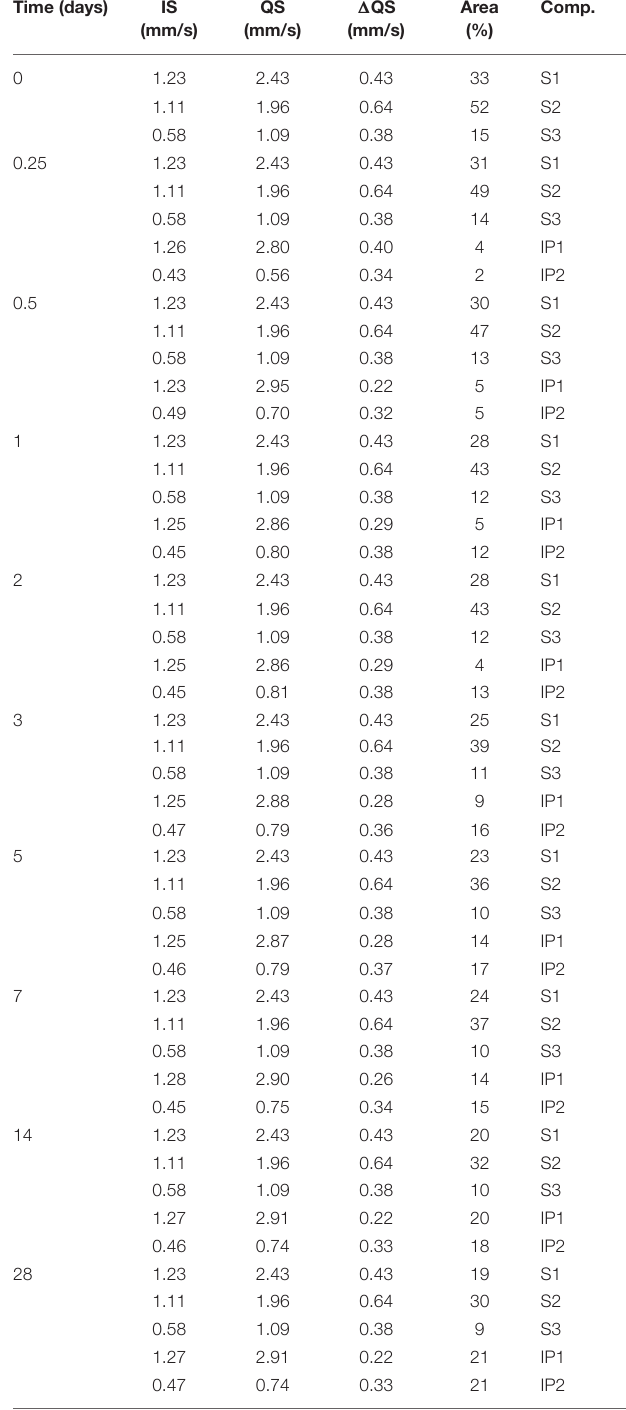
TABLE 2 | Resulting hyperfine parameters values of the components used to fit the 57 Fe Mössbauer spectra. Time (days) IS